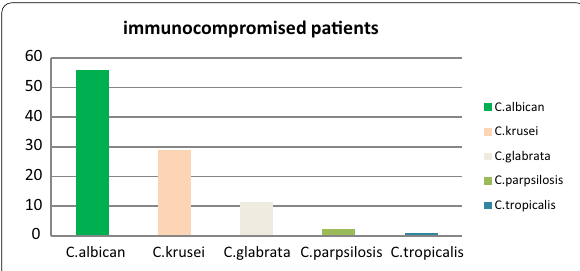
Fig. 2 Incidence of different candida species among studied immunocompromised patients